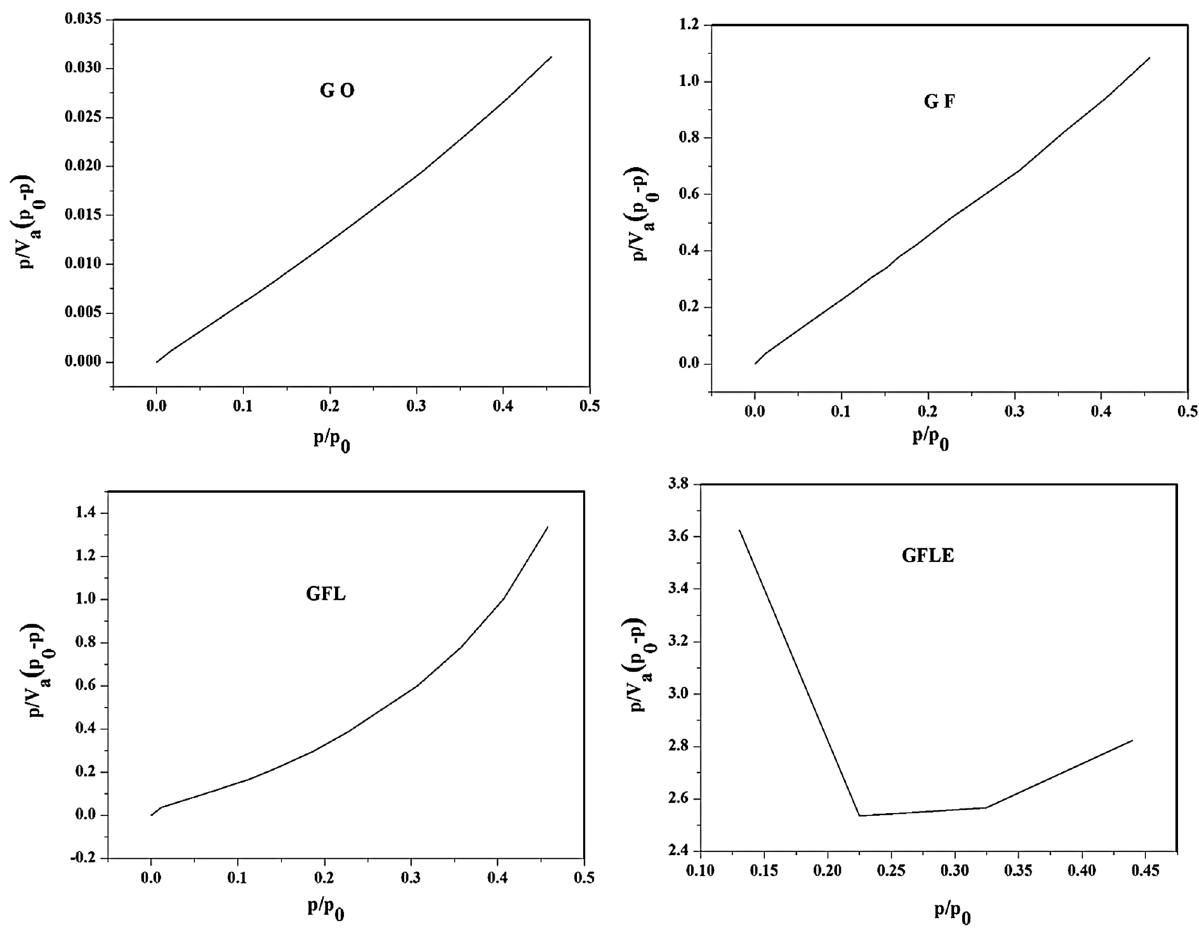
Figure 5. BET curves of GO, GF, GFL and GFLE.